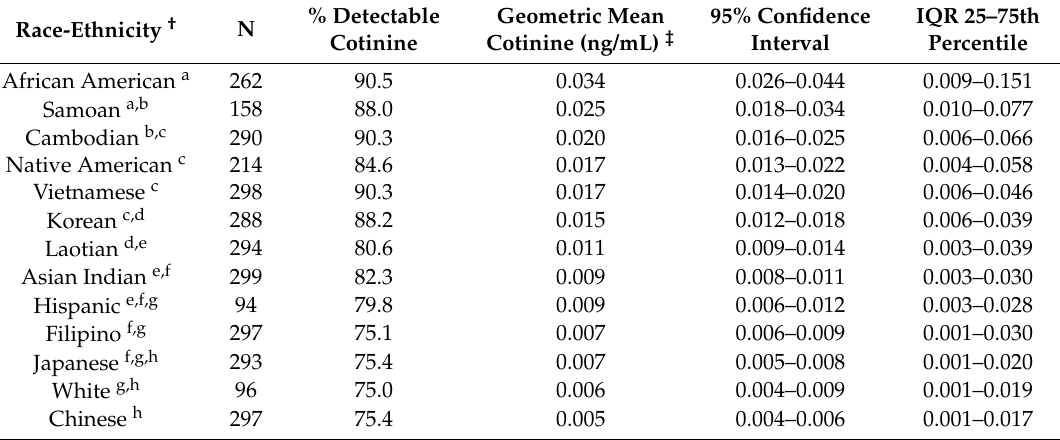
Table 3. Comparisons of mid-pregnancy serum cotinine levels between 13 race/ethnic groups of non-smoking * prenatal screening program enrollees; mean geometric serum cotinine levels with 95% confidence intervals; percent detectable serum cotinine; and interquartile ranges; San Diego, Orange and Imperial counties (N = 3180).